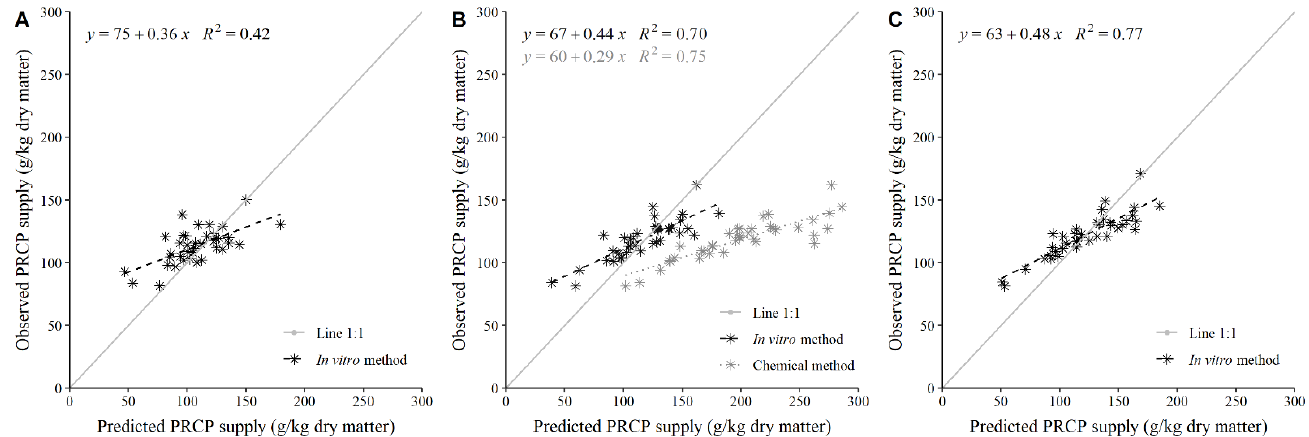
Figure 1. Relationship between post-ruminal protein (PRCP) supply of 23 fresh forage grasses and 15 fresh forage legumes that are commonly used in domestic cattle feeding in the tropics and subtropics estimated with a reference method [15] (observed PRCP) and with an in vitro method (i.e., modified Hohenheim gas test; predicted PRCP) evaluated at Kp of 2%/h ( A ), 5%/h ( B ), and 8%/h ( C ), or with a chemical method [5] at Kp of 5%/h ( B ).